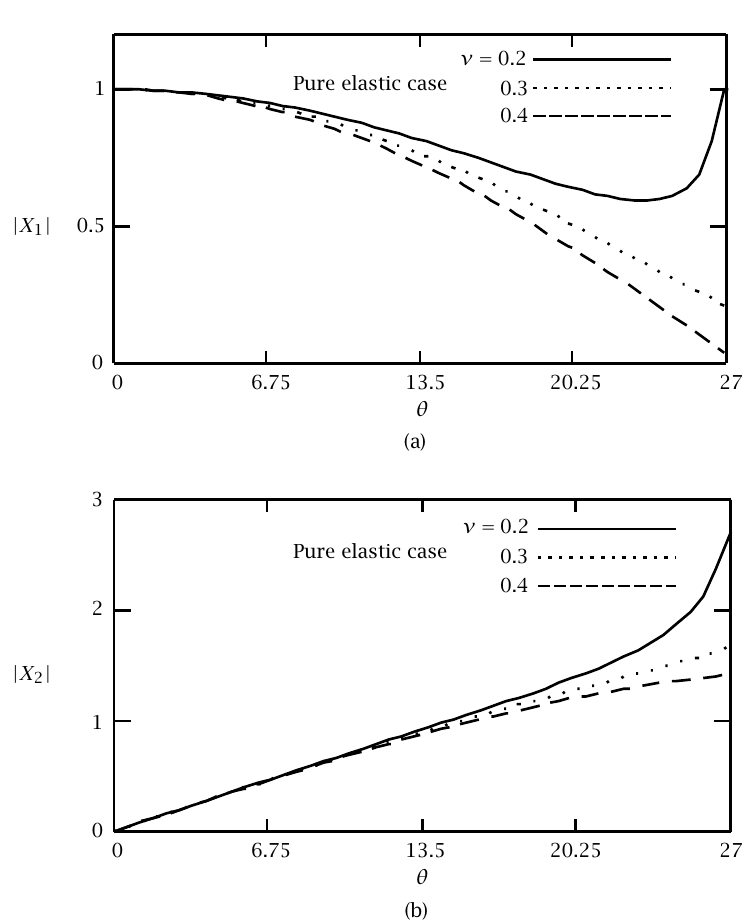
Figure 11 . Pure elastic case. | X 1 | , | X 2 | versus the angle of incidence θ